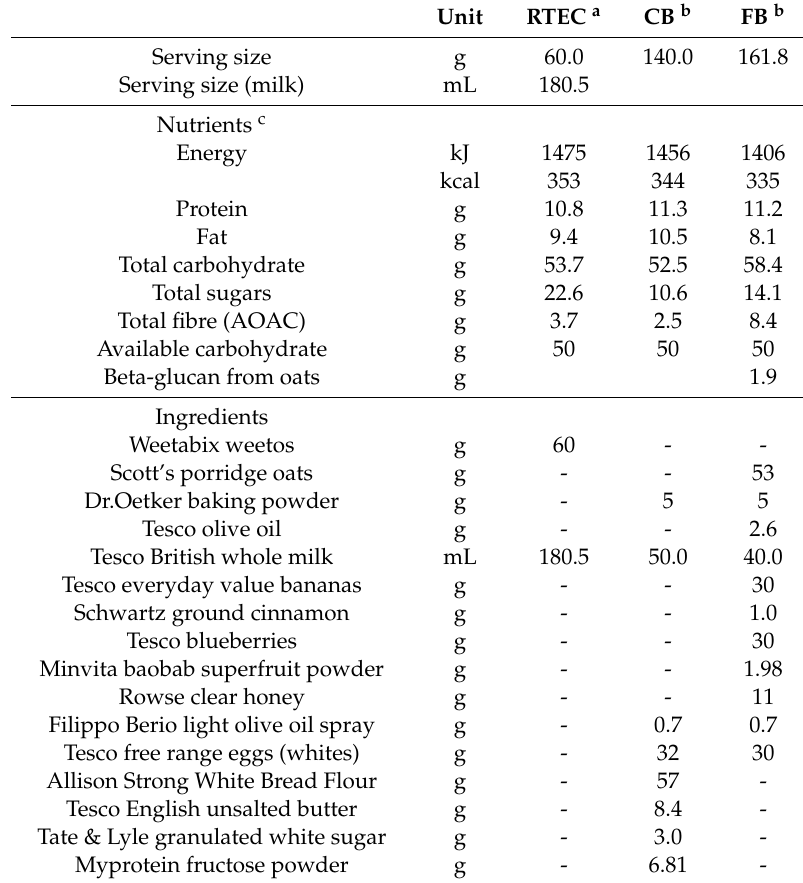
Table 1. Nutrients and ingredients of the breakfast meals (per